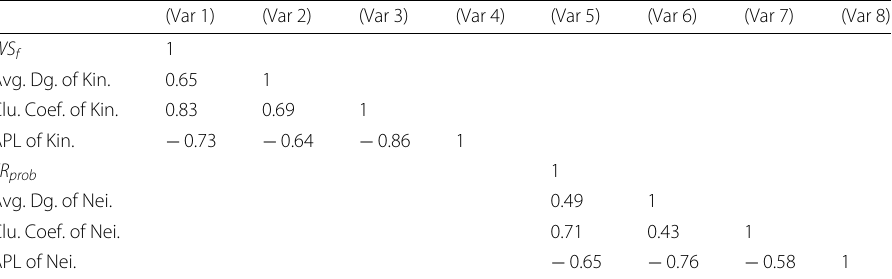
Table 3 Correlations between network characteristics (positive externality effect)